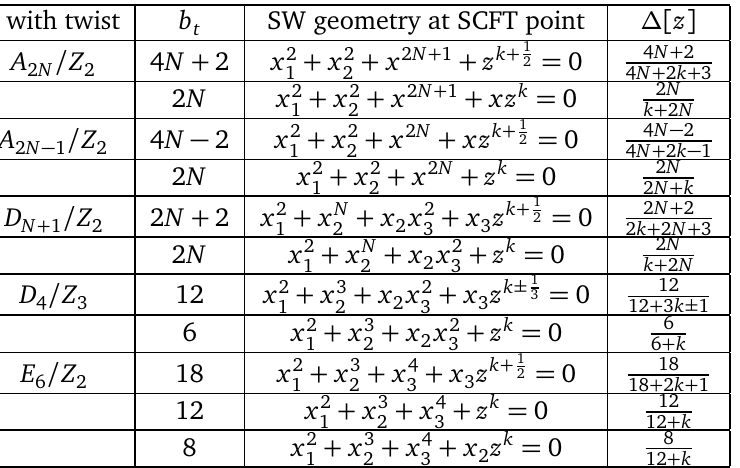
Table 3: Seiberg-Witten geometry of twisted theories at the SCFT point.